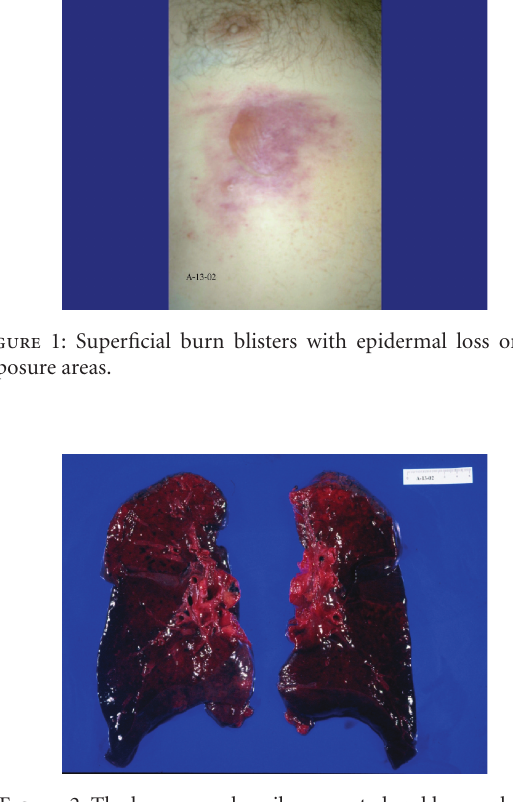
Figure 2: The lungs were heavily congested and hemorrhagic.